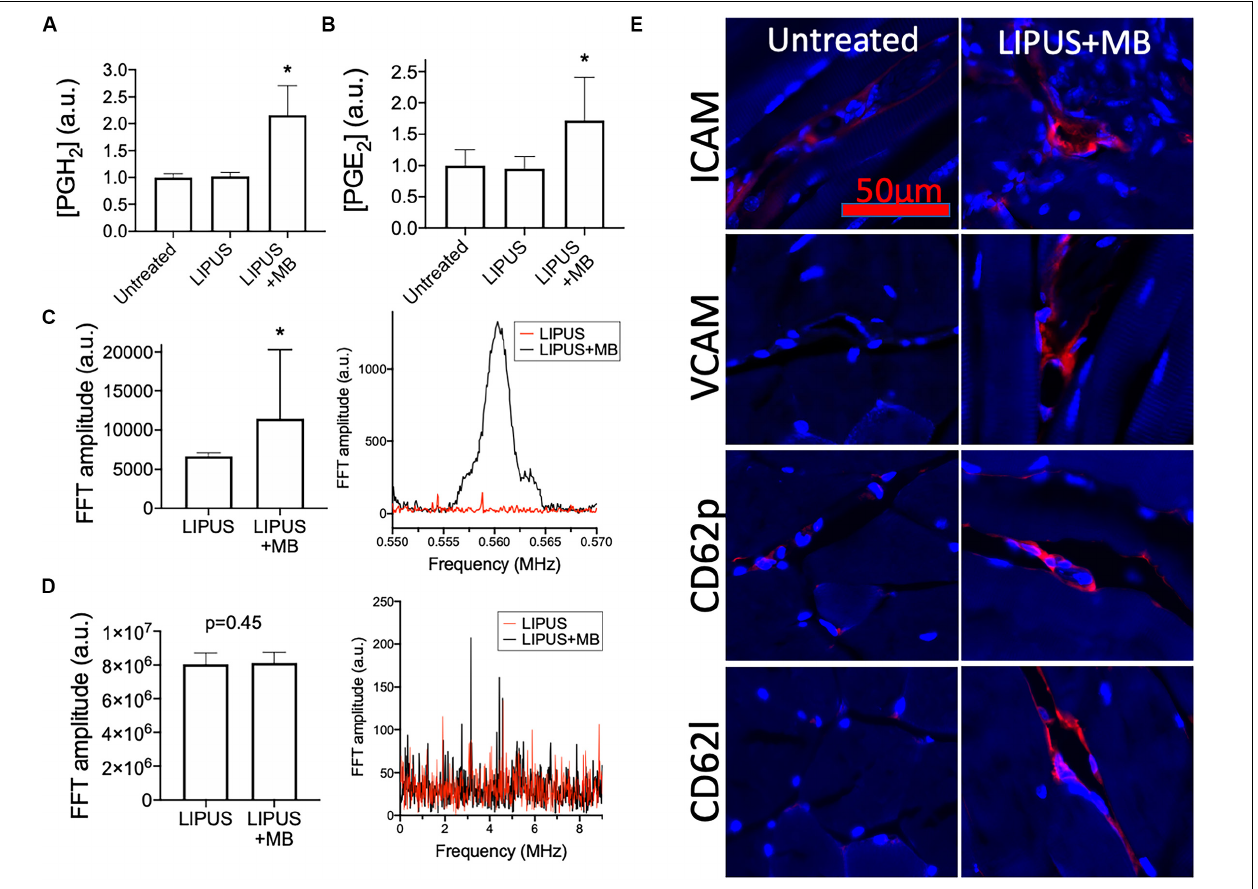
FIGURE 4 | LIPUS + MB alters skeletal muscle microenvironment and increases homing of systemically infused MSC. Mice ( n = 6 per group) were given LIPUS + MB or LIPUS alone and relative expression of PGH 2 (A) and PGE 2 (B) were quantified at 6 h post-sonication. Only LIPUS + MB significantly increased prostaglandin levels ( p < 0.05 by ANOVA). LIPUS + MB increased half-harmonic emissions (C) ( p < 0.05 by t -test) without increasing broadband emissions (D) ( p = 0.45 by t -test). Immunohistochemistry for CAM (E) reveal upregulation of ICAM, VCAM, CD62p, and CD62l (all shown in red) at 6 h-post sonication compared to untreated muscle. Asterisks indicate statistical significance ( p < 0.05) by ANOVA in (A,B) or by t -test in (D)